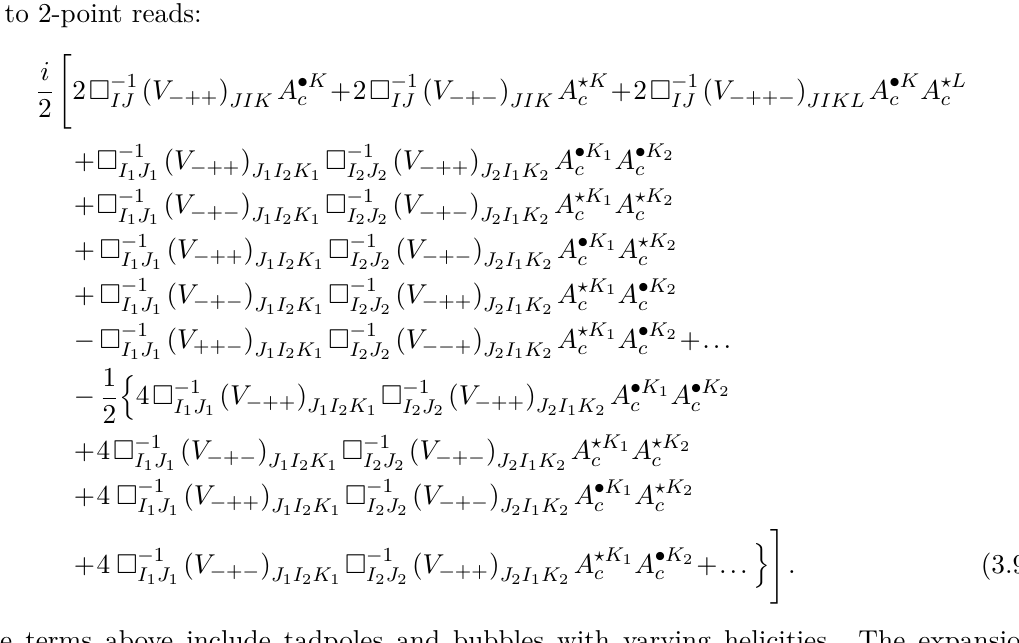
Figure 2 . The diagrammatic content, up to 3-point, of the logarithm term in one-loop effective action for the Yang-Mills theory. For simplicity, we suppressed the symmetry factors and signs associated with each diagram. The external lines with blobs represent ˆ A • After factoring out the inverse propagator, the explicit expansion of the logarithm term up to 2-point